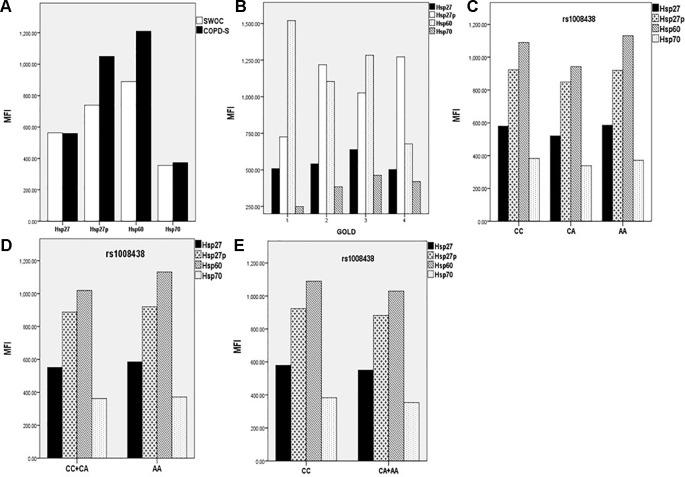
MFI (Median Fluorescent Intensity) comparison between SWOC vs. COPD-S for intracellular Hsp. Significant differences in Hsp27p (p=0.01) and Hsp60 (p = 0.025) were observed (A). GOLD stratification comparing Hsp levels (B), stratifying by rs1008438 genotypes (C), recessive model (D) and dominant model (E). No significant differences were found for any protein in genotype model analysis.